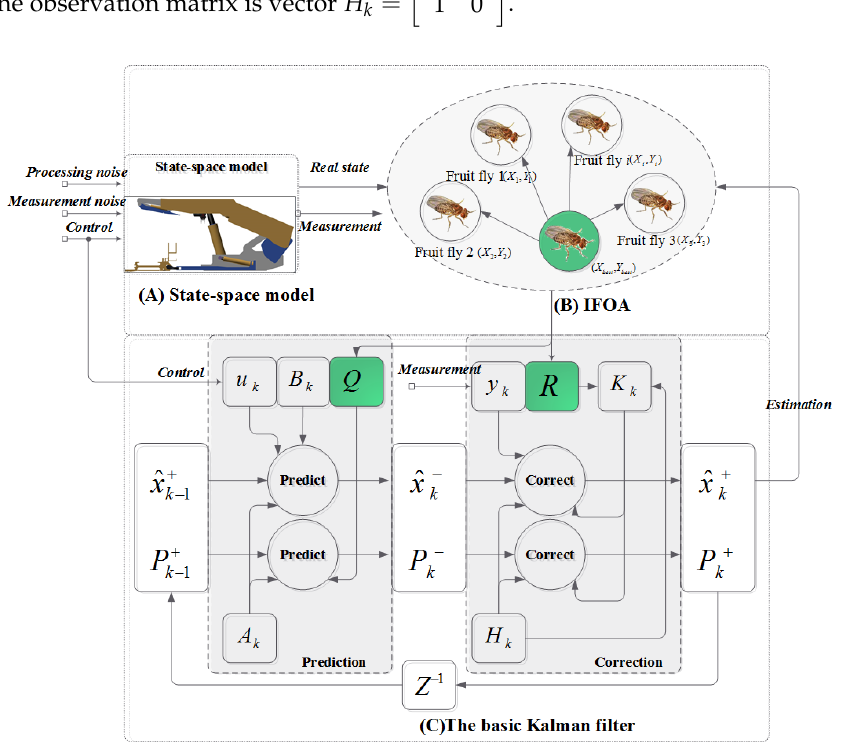
Figure 4. Block diagram of the offline Kalman filter tuning procedure based on IFOA; ( A ) the state-space model of pushing distance estimation; ( B ) the diagram of proposed IFOA; ( C ) the basic Kalman filter.